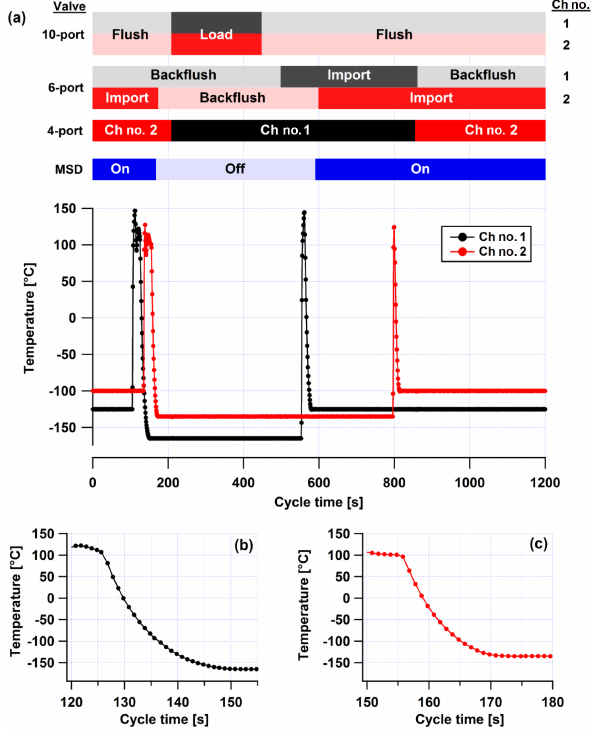
Figure 3. (a) Valve positions and temperature profile of sample traps for an analysis cycle. The 10-port valves control flow to the water and sample traps, the 6-port valves control flow to the sep- aration columns and the 4-port valve controls flow to the detector. (b) For Ch no. 1 trap, the exponential rate of cooling ≈ 8.4s and the trap is cooled from 100 to − 165 ◦ C in 25s. (c) For Ch no. 2 trap, the exponential rate of cooling ≈ 7.0s and the trap is cooled from 100 to − 135 ◦ C in